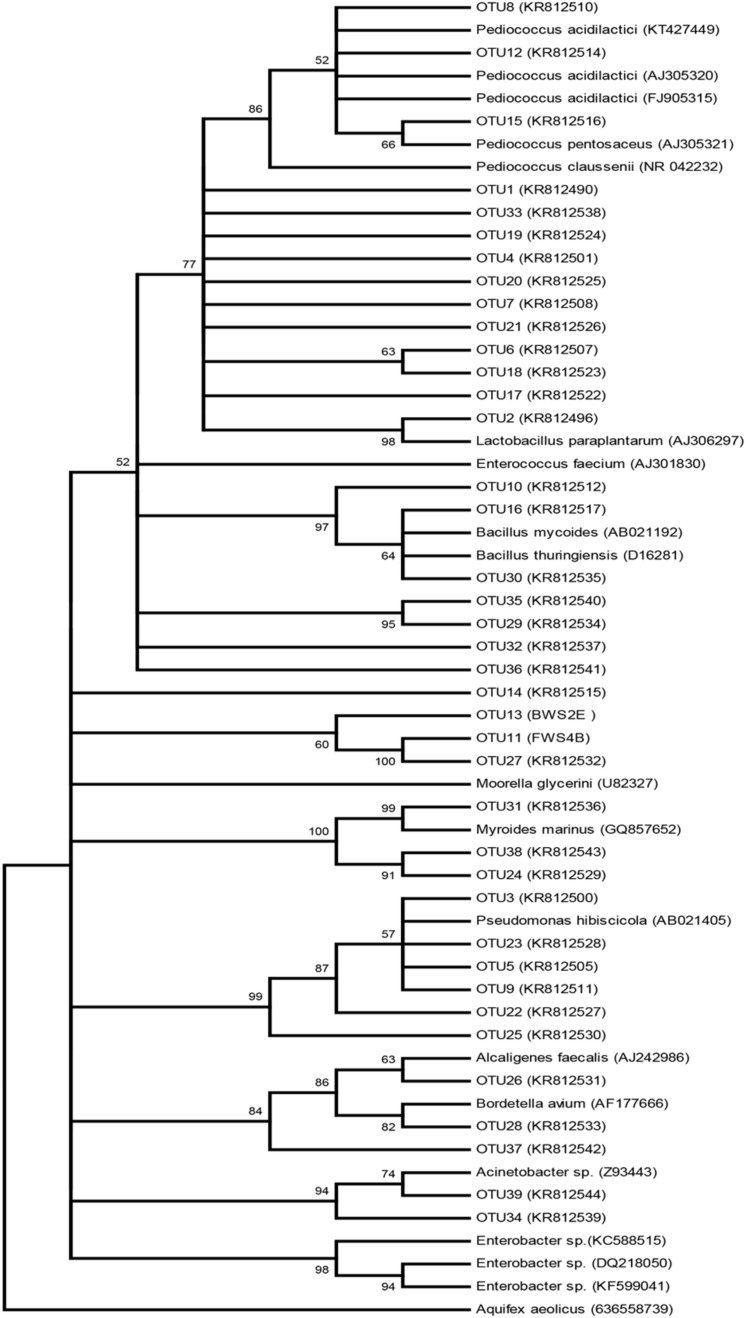
Phylogenetic tree illustrating major bacterial taxa identified during steeping of maize for ogi production and their relatives obtained from the Seqmatch (RDP).